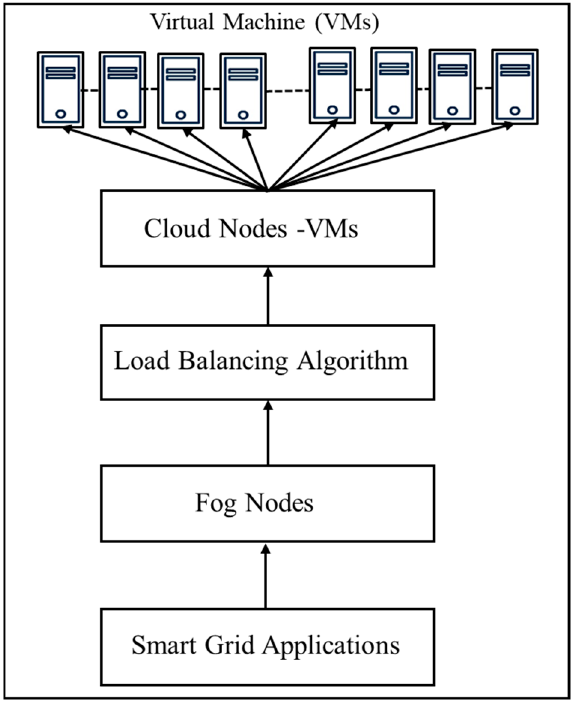
Figure 2. Load Balancing Process.